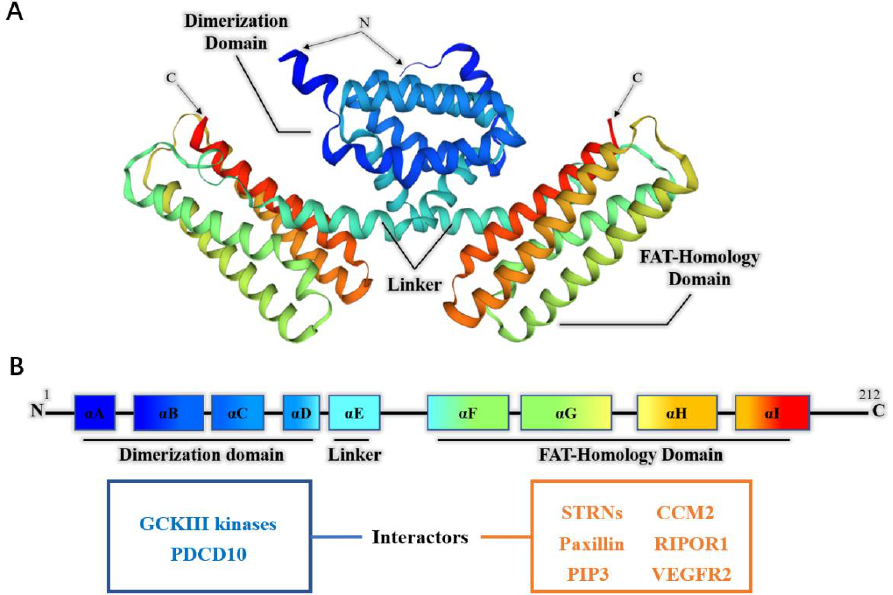
Figure 1. The structure and interactors of PDCD10: ( A ) the crystal structure of homodimerized PDCD10 and ( B ) the model of amino acid sequence, domains, and interactors of PDCD10.